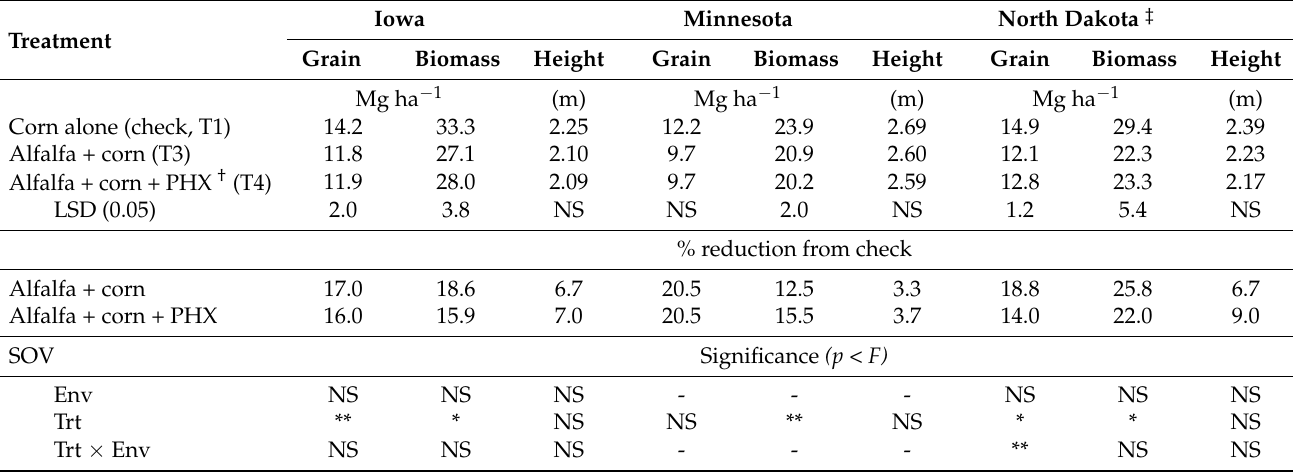
Trt × Env NS NS - - - NS NS